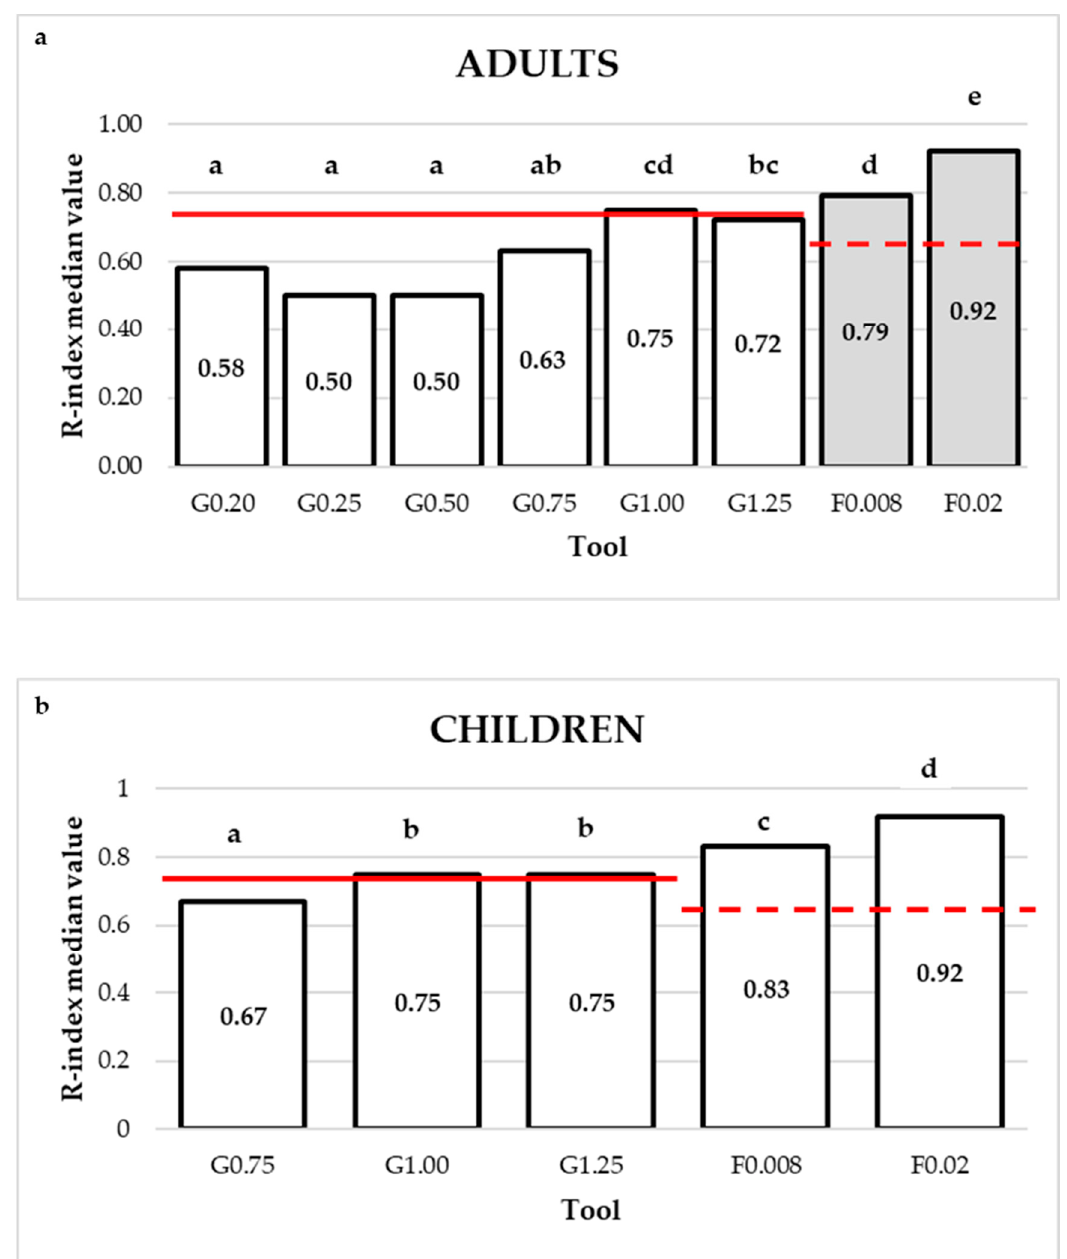
Figure 5. ( a , b ). R-index median values by age and tool. The full and dashed lines indicate, respectively, the R-index discrimination cut-offs for gratings (G) ( R = 0.74) and filaments (F) ( R = 0.63). Values marked with different letters are significantly different (Dunn-Bonferroni test, p < 0.05).